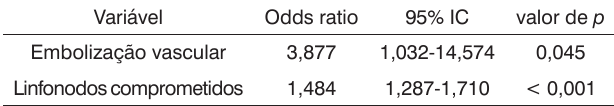
Tabela 1. Sítio dos tumores primários dos pacientes incluídos nesta série.